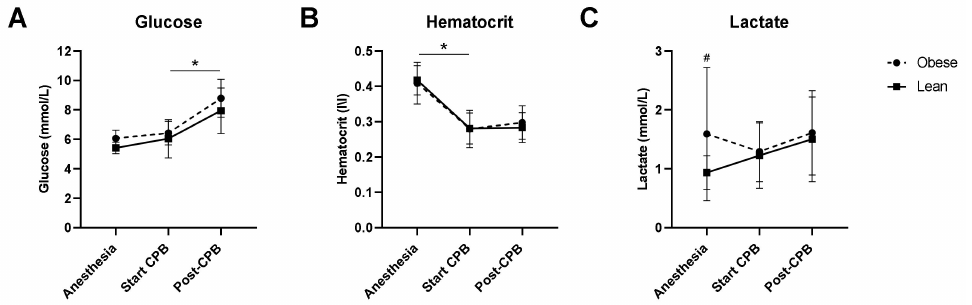
Figure 2. Intraoperative glucose, hematocrit, and lactate levels. Glucose ( A ), hematocrit ( B ), and lactate ( C ) measured after induction of anesthesia (anesthesia), 10 min after start of cardiopulmonary bypass (start CPB), and 10 min after weaning from CPB (post-CPB) in lean (black line) and obese (dotted line) patients. Data are represented by mean ± SD and tested with a two-way ANOVA and Bonferroni post hoc analysis; * p < 0.05 time effect; # p < 0.05 obese vs. lean